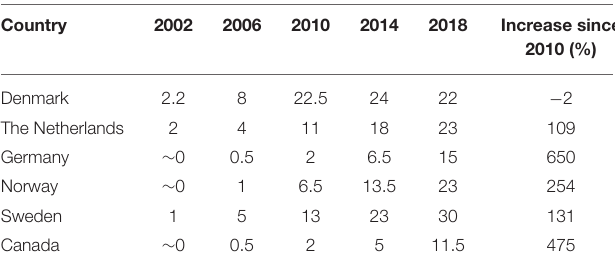
ADOPTION OF AMS IN DIFFERENT DAIRY TABLE 1 | Automatic milking system adoption rates from 2002 to 2018 in several dairy producing countries (% of total farms in each country, rounded to nearest